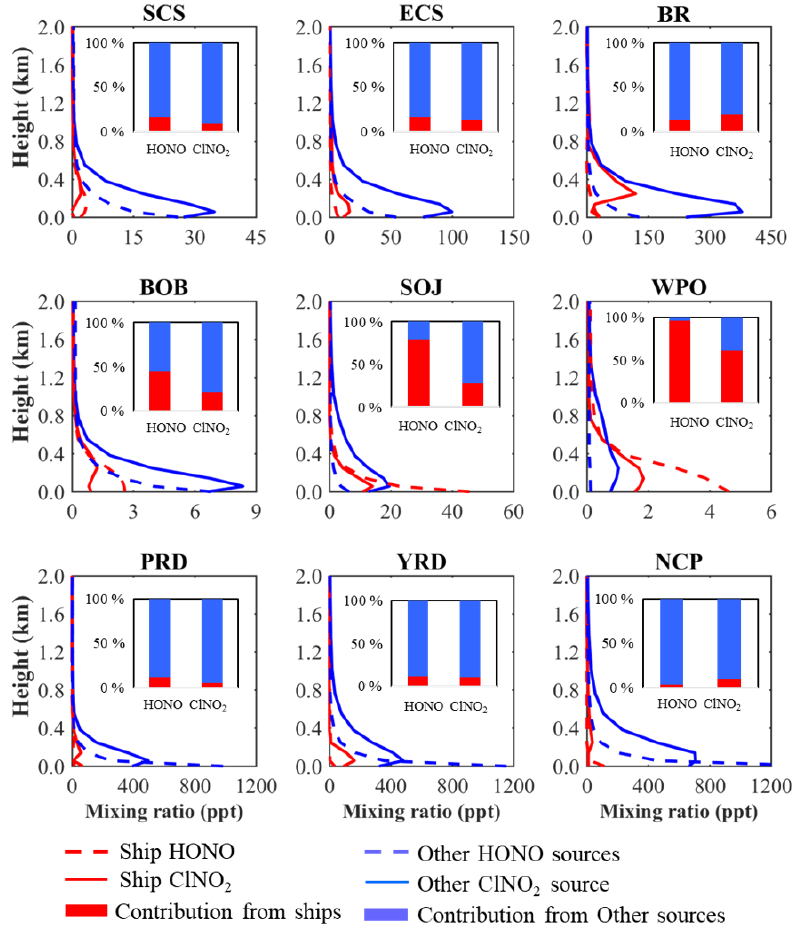
Figure 3. Vertical profiles of simulated HONO and night-time ClNO 2 (in ppt) from ship emissions and other sources in the nine regions. Also shown are the contributions of ship emissions and other sources to averaged HONO and night-time ClNO 2 levels in the marine boundary layer (within